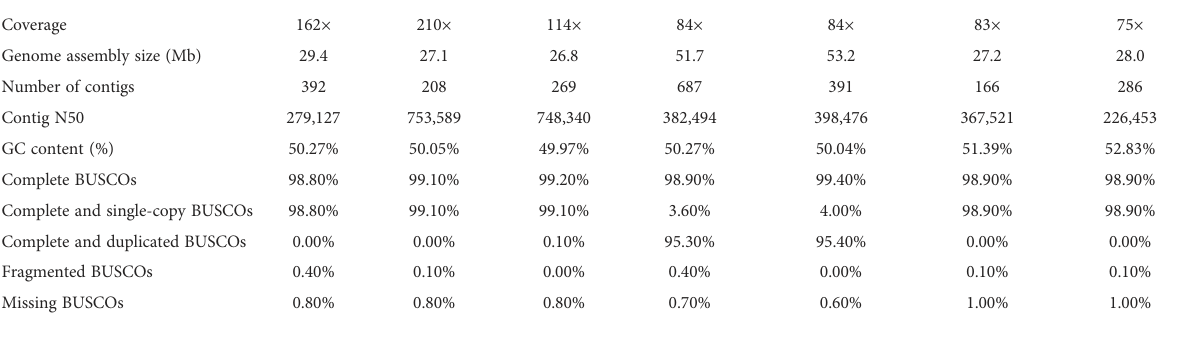
TABLE 1 Genome characteristics and assembly quality